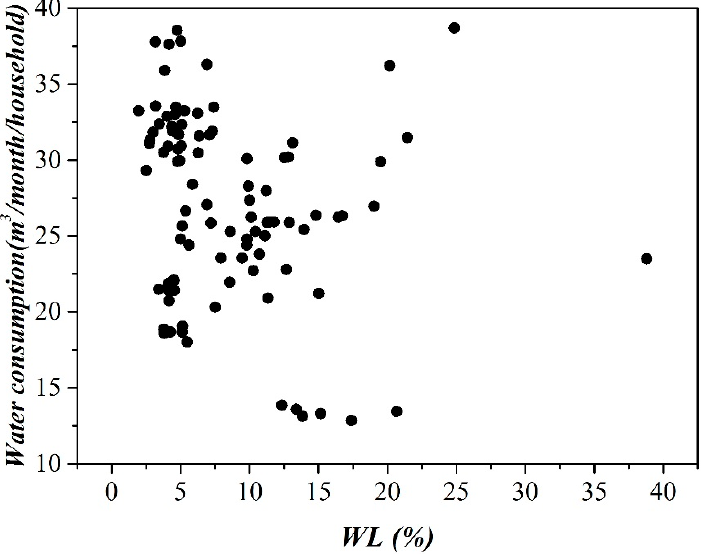
Figure 2. The relationship between WL (%) and water consumption ( WL : the ratio of unoccupied houses on the rental market to the total number of households).